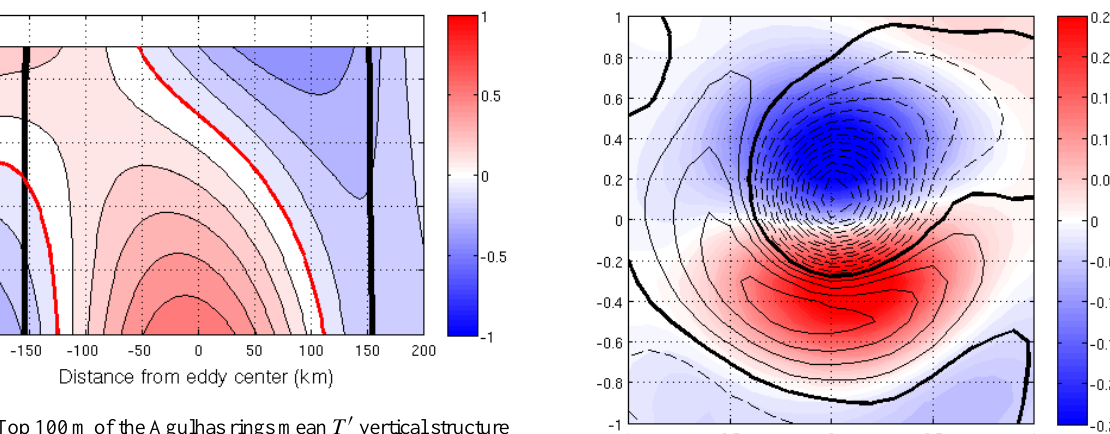
Figure 3. Time series of the mean T' in the eddy thermal centers (thick line) showing the persistence of negative (cold) values. The thin gray lines indicate the maximum and minimum values of T' at the eddy thermal centers between the different rings identified at each time, showing that all observed structures presented cold cores.